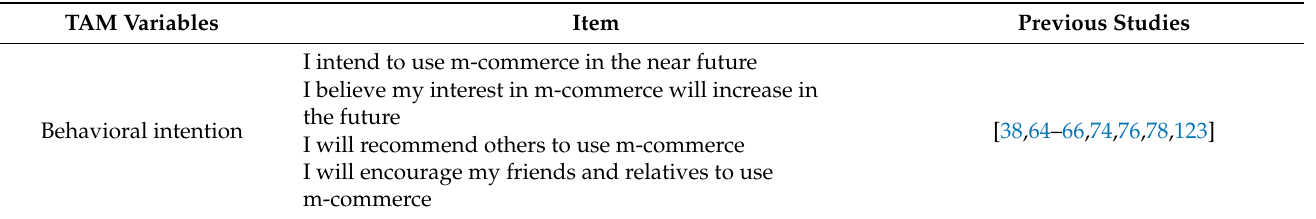
Table 1. Summary of the variables included in the